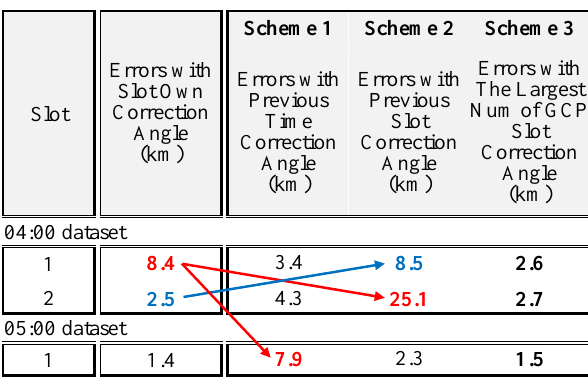
Table 3. Error propagation of the three schemes In many cases of slot 1 and 2, scheme 3 showed the better quality than other schemes. Due to the small number of GCPs in slot 1 and 2, the performance of the correction angle was mostly poor. As shown in Table 3, error propagation increased when reusing a correction angle with poor performance. Therefore, if the previous time or slot correction angle performance is poor, scheme 3 showed better accuracy than other